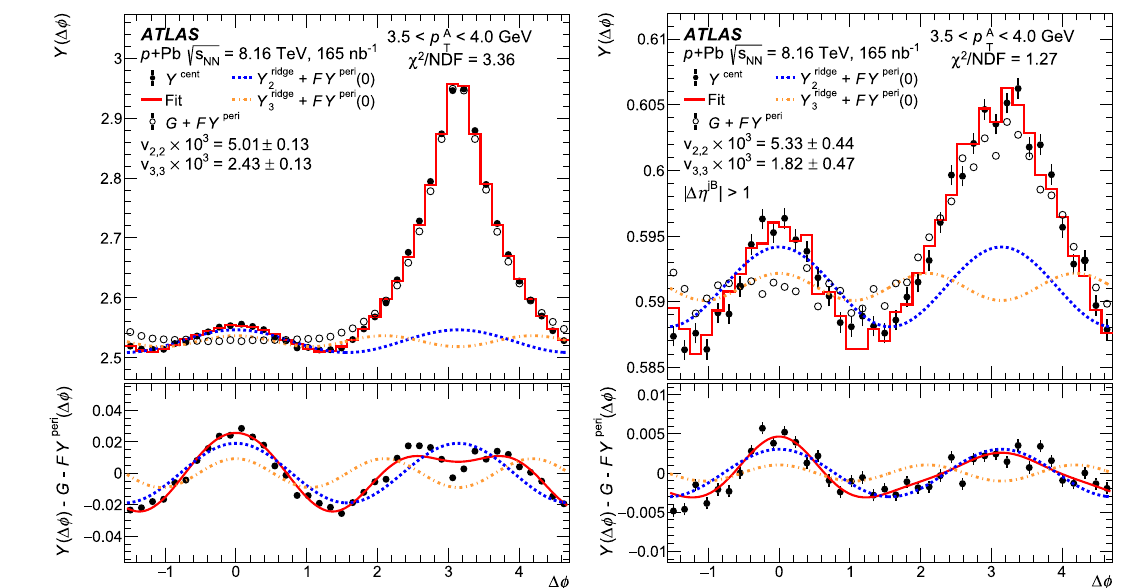
Fig. 1 Template fitting output for events with jet p T > 100 GeV. Both and harmonic functions). The blue dashed line shows the second-order < 4 . 0 GeV and are made with 60–90% peripheral require 3 . 5 < p A harmonic component, Y ridge , andtheorange dottedlineshows thethird- T 2 selection and 0–5% central selection. The left plot is made with no order harmonic component, Y ridge (the n = 2 and n = 3 contributions 3 selection on the B-particles and the right plot is made requiring the to the sum in Eq. 1, respectively). The lower panels show the difference > 15 GeV B-particles to have | (cid:8)η jB | > 1 relative to all jets with p jet between the central data and the peripheral template along with the sec- T in the event. In the upper panels, the open circles show the scaled and ond and third harmonic functions. The resulting v 2 , 2 , v 3 , 3 , and global shifted peripheral template with uncertainties omitted, the closed cir- fit χ 2 /NDF values are reported in the legends. In these fits, NDF = cles show the central data, and the red line shows the fit (template